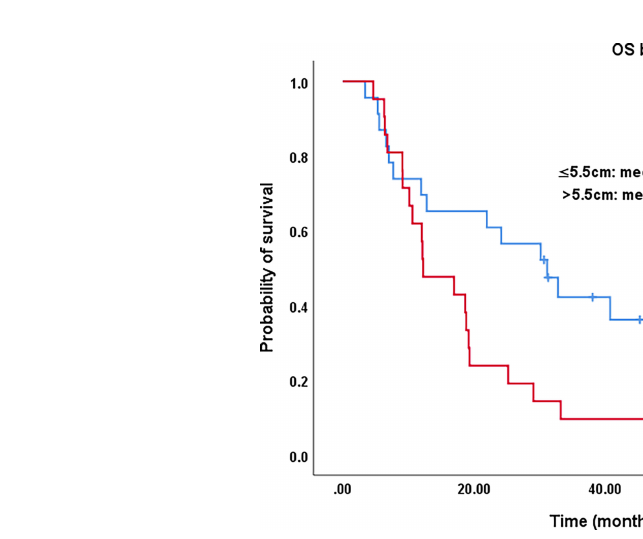
TABLE 4 | Cox regression multivariate analysis of survival predictors for OS. Variables